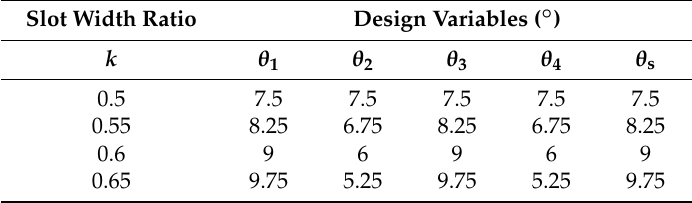
Table 2. Dimensions of the design variables according to the slot width ratio, k